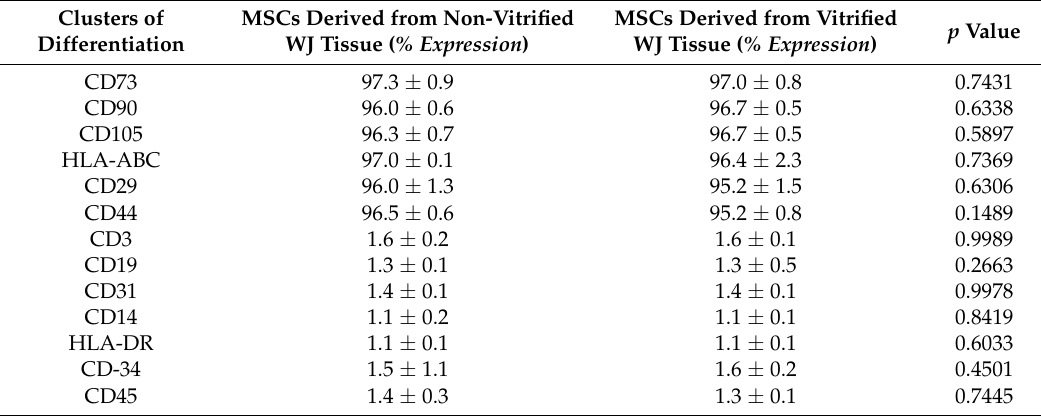
Table 2. Flow cytometric analysis of MSCs derived from non-vitrified (n = 3) and vitrified (n = 3) WJ-tissue